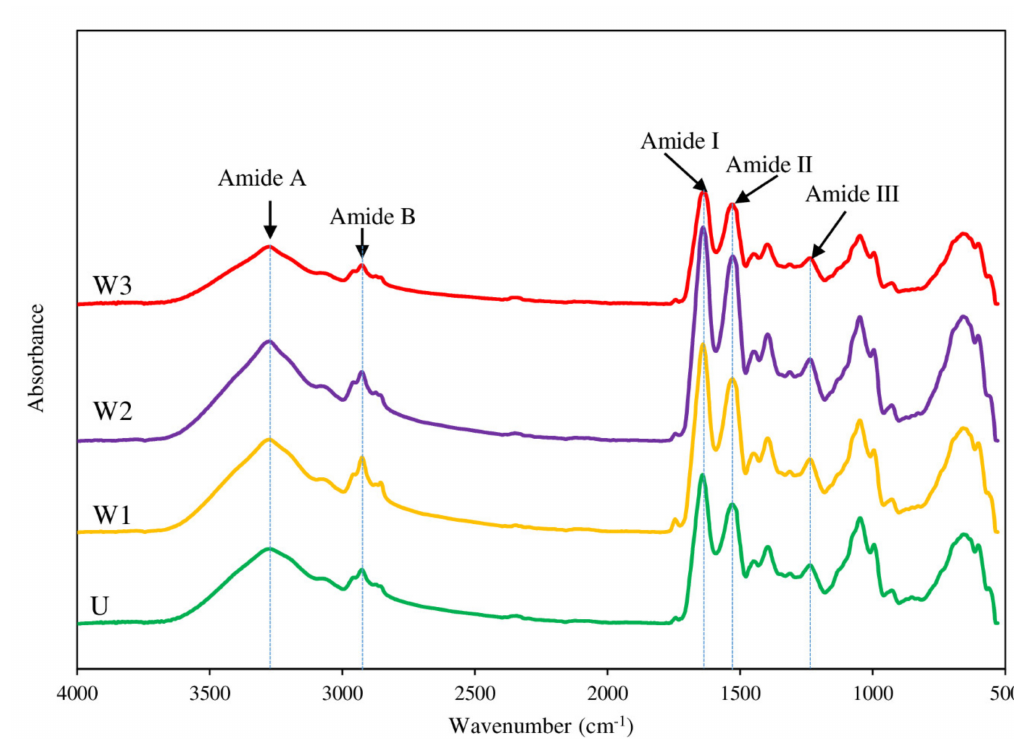
Figure 3. FTIR spectra of gels from unwashed mince (U) and surimi from Indian mackerel prepared by one washing cycle (W1), two washing cycles (W2), and three washing cycles (W3).